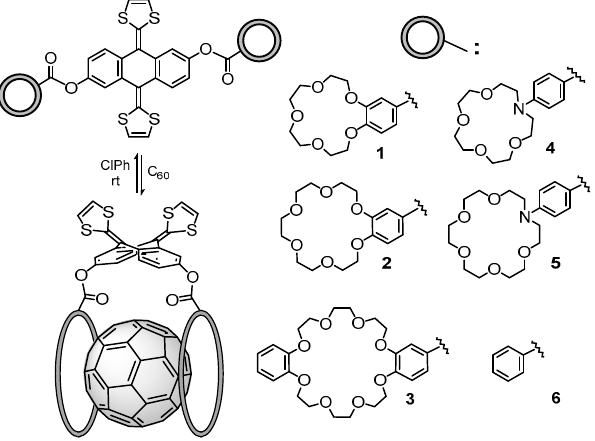
Figure 3. Complexes obtained from exTTF-based 1 – 6 and C 60 . Reproduced from Reference [84] with permission from the Royal Society of Chemistry.